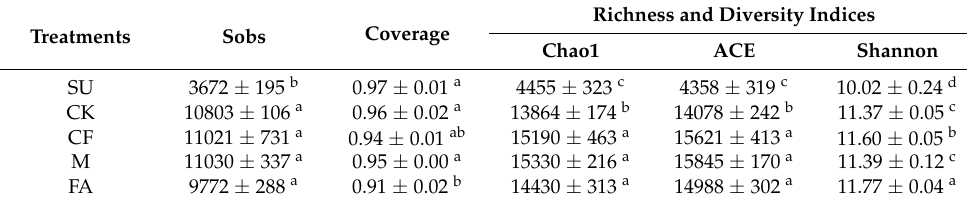
Table 2. Estimated number of observed Sobs, coverage, richness, and diversity in different treatments.